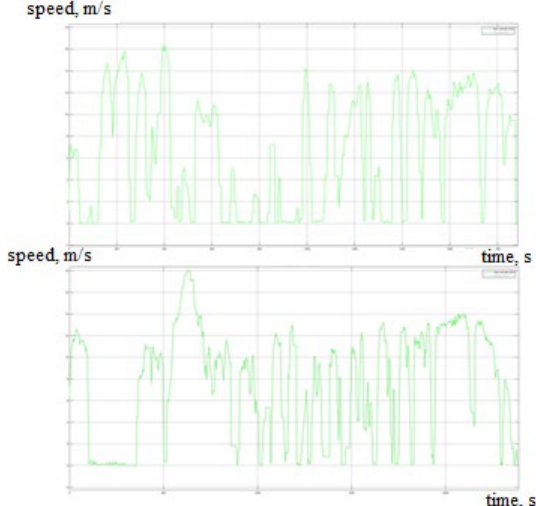
Fig. 2. Speed time diagrams of routes 5 and 2 correspondently applied to modelling.